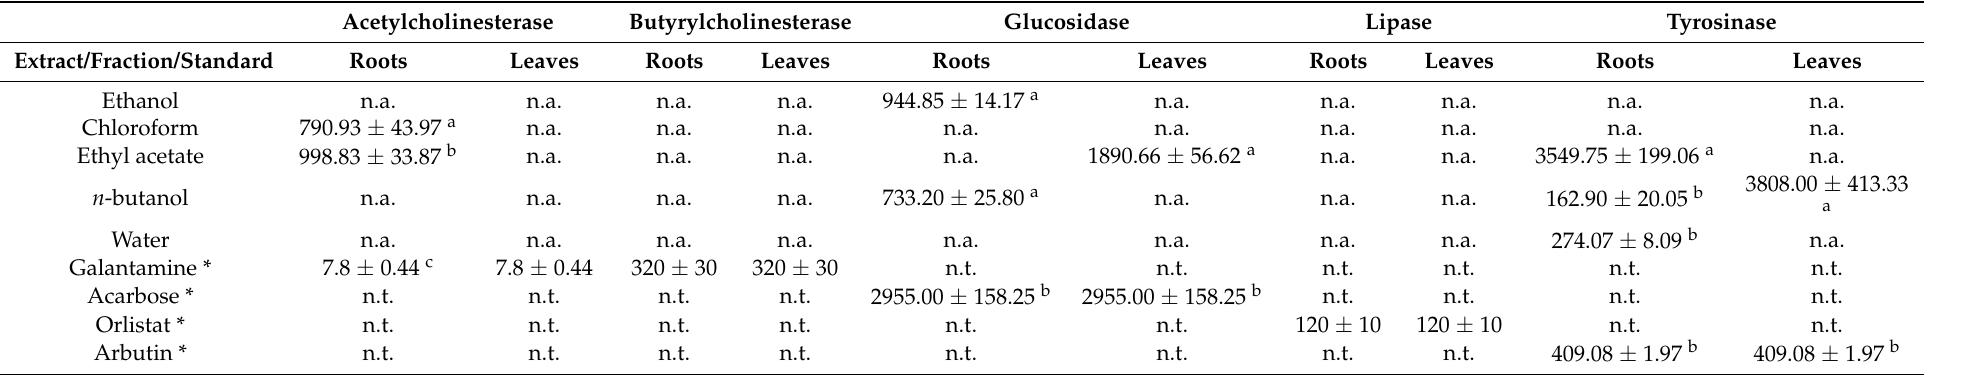
Table 4. Enzymatic inhibitory properties of ethanol extracts from L. intricatum and obtained fractions. Results are expressed as IC 50 values ( µ g/mL). Acetylcholinesterase Butyrylcholinesterase Glucosidase Lipase Tyrosinase Extract/Fraction/Standard Roots Leaves Roots Leaves Roots Leaves Roots Leaves Roots